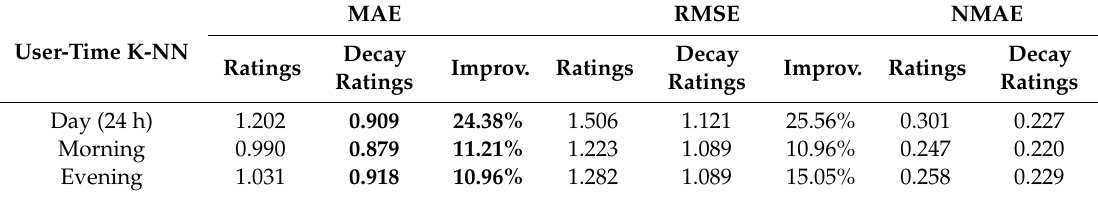
Table 4. Values of the RMSE, MAE and NMAE obtained for the rating prediction in different time periods using the user-time K-NN method.